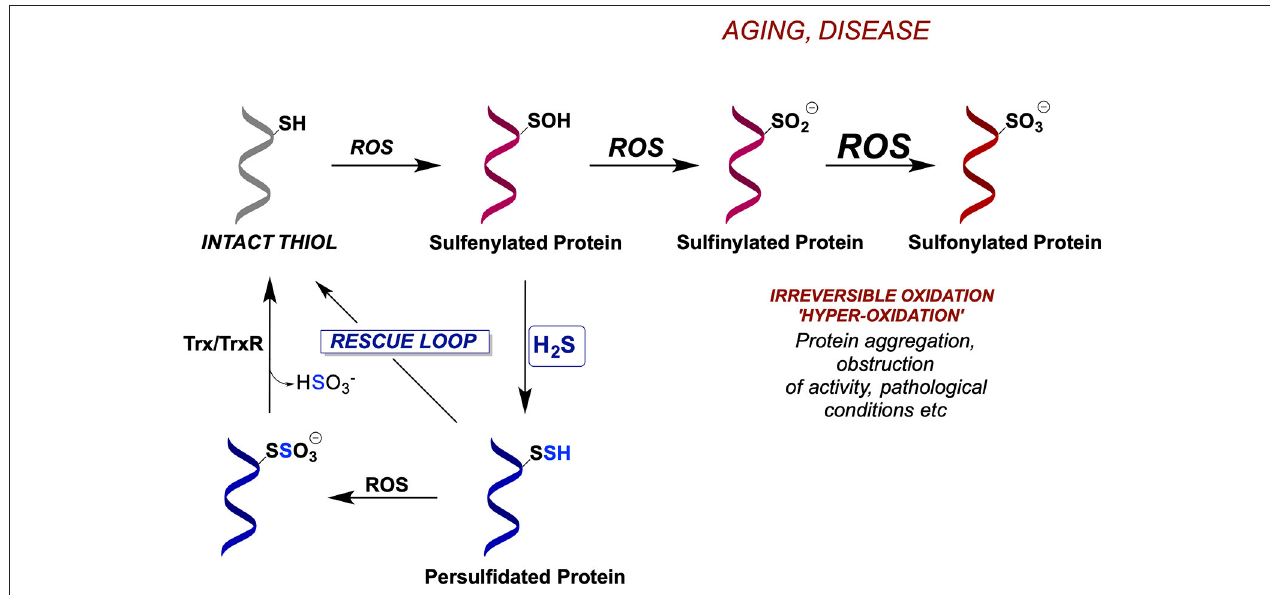
FIGURE 4 | Evolutionarily conserved mechanism for cellular protection by protein persulfidation. Due to their increased nucleophilicity, persulfides are better scavengers of ROS than cysteines resulting in the formation of S-sulfonates, which could potentially be reduced by thioredoxin/thioredoxin reductase system (Trx/TrxR), restoring back the thiolates. In the absence of H 2 S, cysteine residues become irreversibly hyperoxidized leading to protein